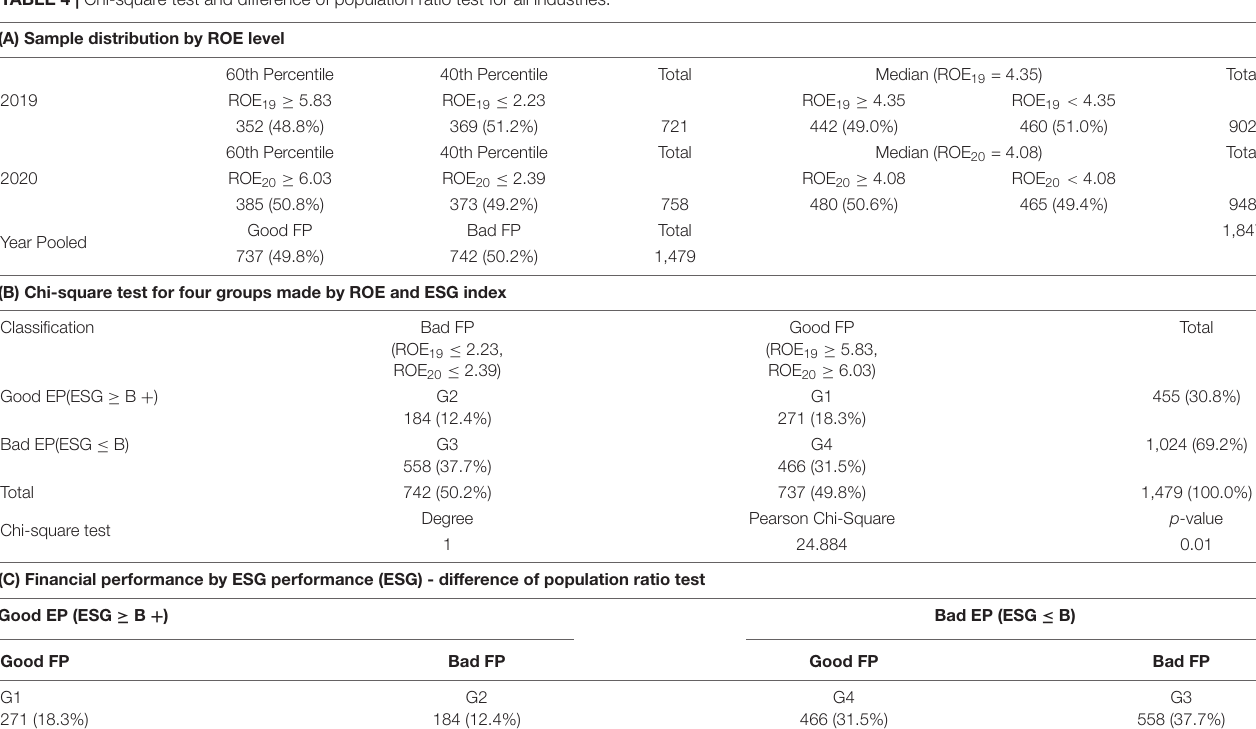
TABLE 4 | Chi-square test and difference of population ratio test for all